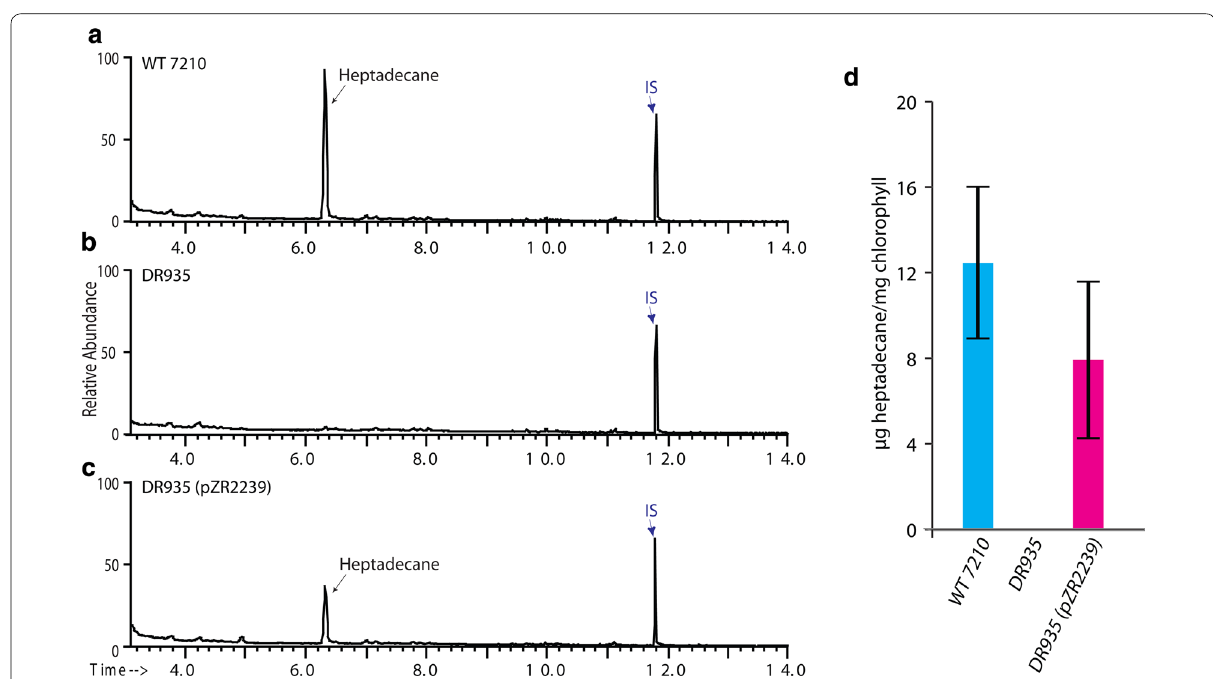
Fig. 4 Alr5283 and Alr5284 are responsible for the heptadecane production in Anabaena 7120. GC/MS SIM chromatographs of the volatile metabolites from wildtype ( a ), DR935 ( b ), and DR935(pZR2239) ( c ) strains, respectively. Heptadecane naturally produced in wildtype Anabaena 7120 was not detected in DR935, but reemerged after the complement plasmid pZR2239 was transformed into DR935. Five μg mL − 1 tetracosane serves as an internal standard (IS, blue arrow). d Total heptadecane production mg − 1 chlorophyll of wildtype Anabaena 7120, DR935, and DR935(pZR2239) cultures from days 0 to 5. Heptadecane yield was calculated by measuring the total heptadecane produced from days 0 to 5 and dividing by total chlorophyll content of the 100 mL cultures measured on day 5. The culture density increased over days 0–5 but only day 5 chlorophyll content was used to make the calculation (the chlorophyll content of seed culture at day 0 is negligible). Therefore, the total heptadecane production mg −